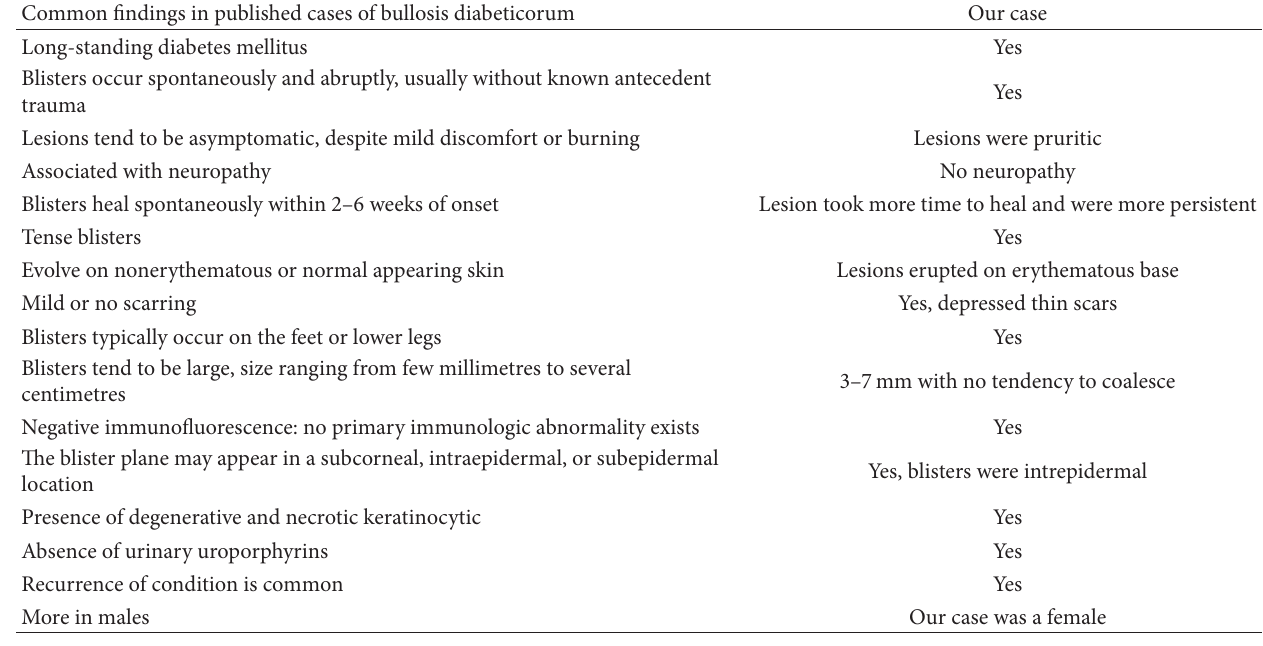
Table 1: Showing the different manifestations of bullosis diabeticorum described in the literature [8, 9] in comparison with our case. Common findings in published cases of bullosis diabeticorum Our